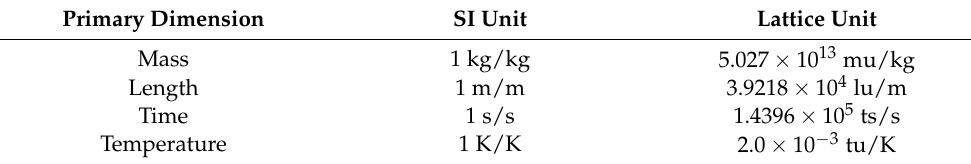
Table 3. Scaling units between SI and lattice